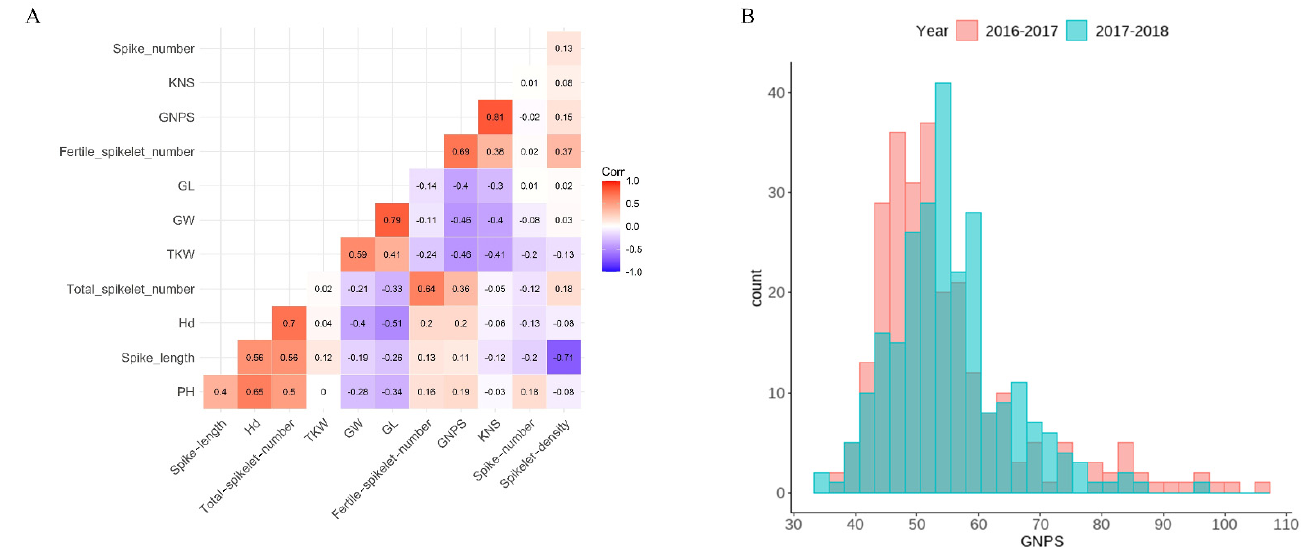
Figure 1. Phenotypic correlation of 12 traits and grain number per spike (GNPS) distribution of different wheat accessions. ( A ) Phenotypic correlation of 12 traits of 259 collected lines. Corr represents the correlation coefficient, and the numbers in the matrix frame denote the value of the correlation coefficient, KNS represents kernel number per spikelet. ( B ) GNPS distribution of different wheat accessions in 2-year replicates 2016–2017 and 2017–2018.